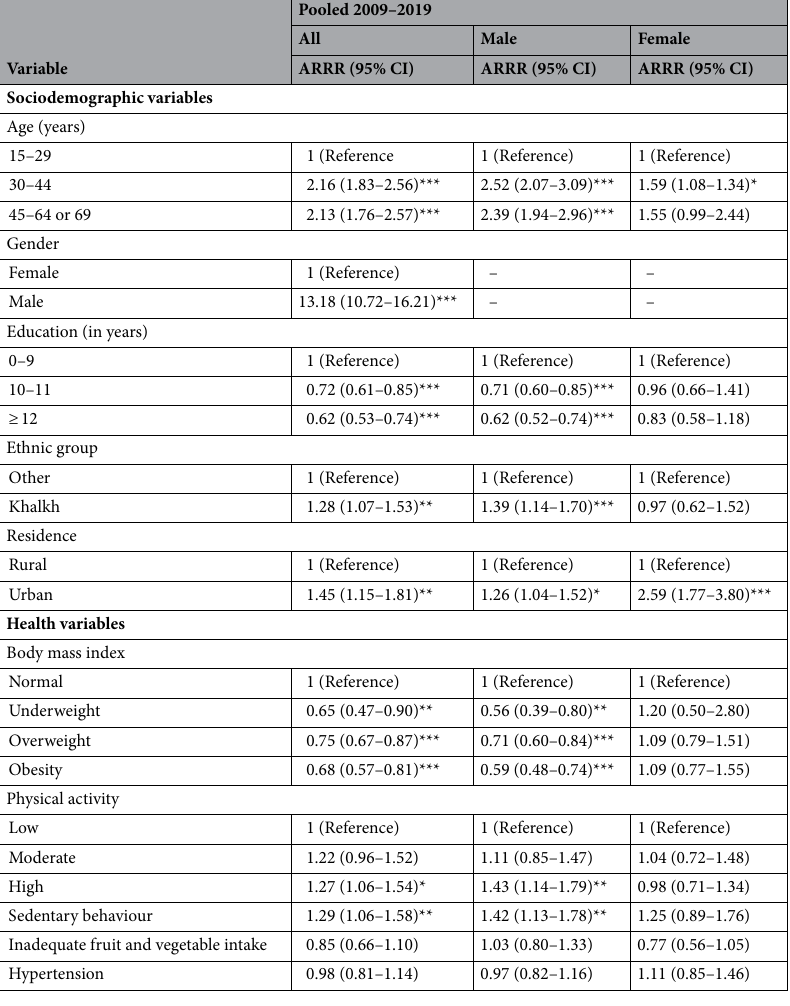
Table 11. Associations with current tobacco use only (with non-current tobacco and non-current heavy drinking as reference category) among 15 years and older individuals in Mongolia, 2009–2019. *** p <